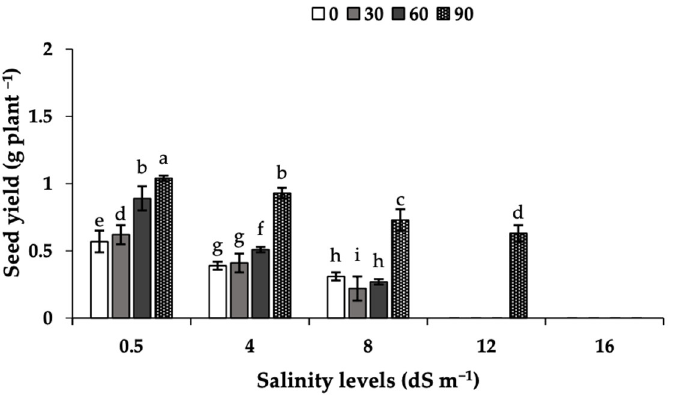
Figure 3. Effects of MEL applications (0, 30, 60, and 90 µM) on seed yield (g plant −1 ) in camelina plants grown under different levels of salinity (0.5, 4, 8, 12, and 16 dS m −1 ). Data shown are means of three replicates per treatment ± SD. Different letters above the columns indicate statistically significant differences at p < 0.05.